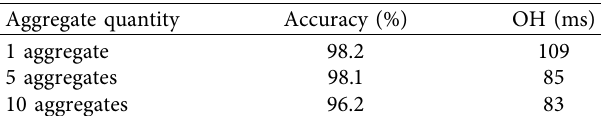
Table 1: Comparison of single aggregate, 5 aggregates, and 10 aggregates.